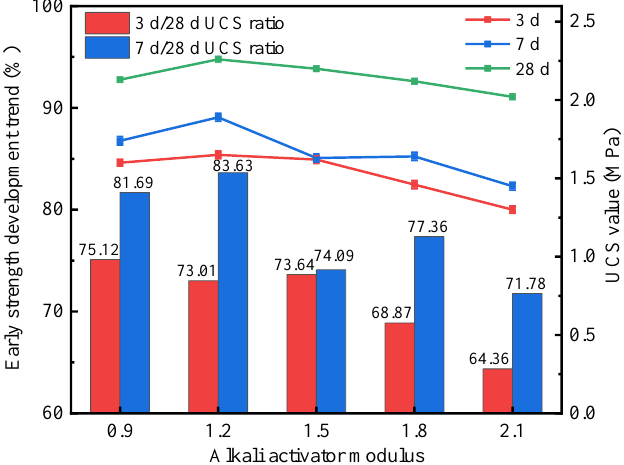
Figure 6. UCS values of stabilized soils with different alkali activator moduli.